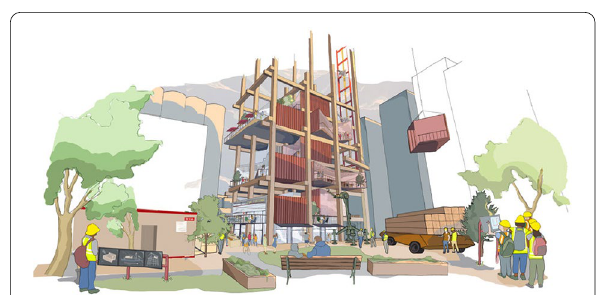
Fig. 7 Artist’s impression of Sidewalk Labs, 2017. © Sidewalk